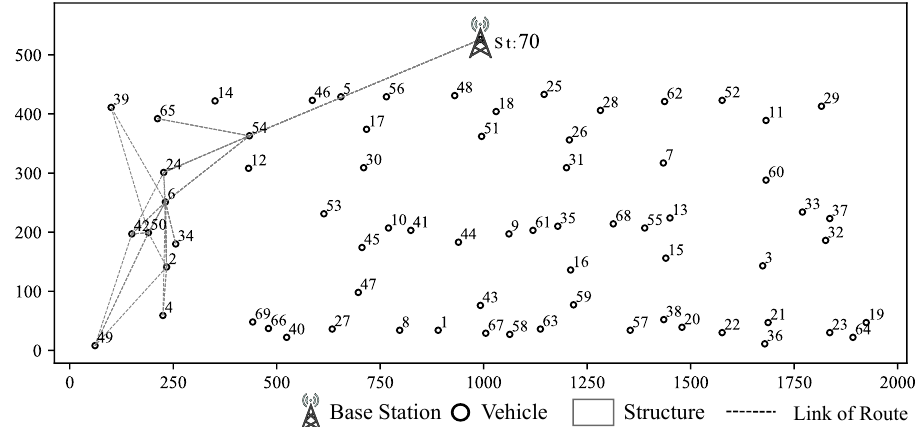
Figure 11. Example of V (cid:42)(cid:41) V Communication Simulation